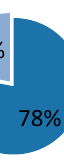
Figure 3. Emission contributions of various sources to the total industrial VOC emissions in Hebei Province in 2015 (CNP: crude oil and natural gas extraction; PR: petroleum refining; BCM: basic chemical raw materials manufacturing; CE: chemical medicine; CP: coke production; MEM: mechanical equipment manufacturing; WA: wood adhesives; PA: packaging adhesive; ICD: industrial and construction dyes; WC: wood coatings; TEC: transportation equipment coating).